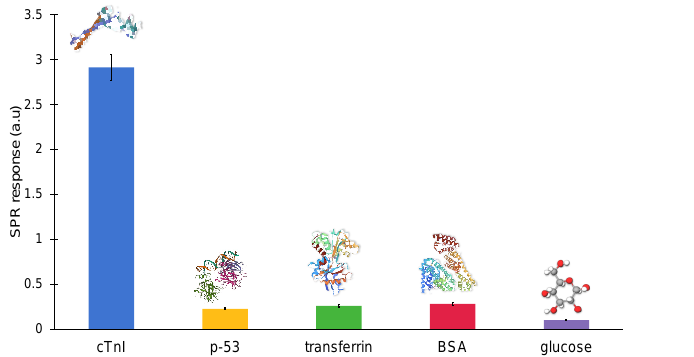
Figure 10. Cross-reactivity studies against non-specific molecules (p-53, transferrin, BSA, glucose) on the epitope-imprinted MIP sensor at a fixed concentration of 100 ng mL −1 .